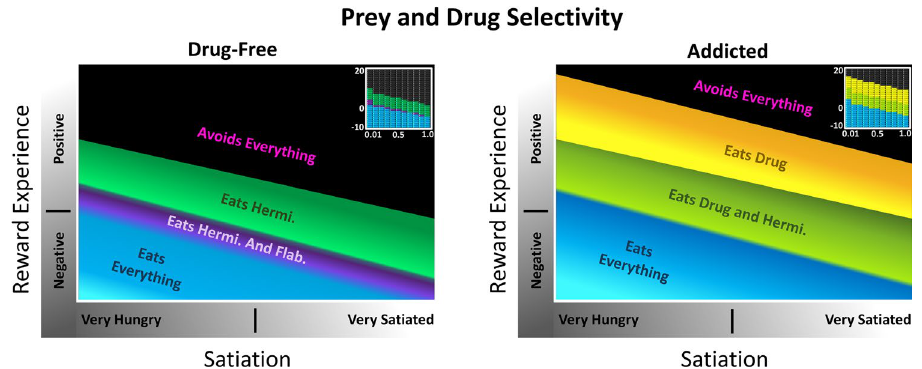
Figure 2. Effects of satiation and reward experience on selectivity for prey and Drug. Relations are smoothed from coarser quantitative data (insets), where satiation is varied from 0.01 to 1.0, and reward experience is varied from − 10 to 20 in Presentation Mode. With enough available Drug in the environment, Drug consumption is favored over prey, leading to a lower nutritional state and low satiation. Selectivity is observed as an approach turn towards specific prey or the Drug. Left : A selectivity map for ASIMOV’s forager naïve to the Drug. Learned associations for benign Hermi and noxious Flab are at maximum associative strength in this environment, with no learned association for the Drug. As prey consumption provides relatively small positive and negative reward experience, reward experience level is largely near zero. Right : An approach turn selectivity map for a forager addicted to Drug. Learned associations for all prey and Drug are at maximum associative strength. Drug consumption gives immediate positive reward and can eventually lead to negative reward experience during withdrawal; thus the forager’s reward experience ranges from negative to positive. In negative reward experiences, like withdrawal, the effect of hunger is increased, and the forager shows less selectivity for prey and Drug. In high positive reward experience, there is increased selectivity for the Drug, so nutritional needs are often ignored in favor of Drug